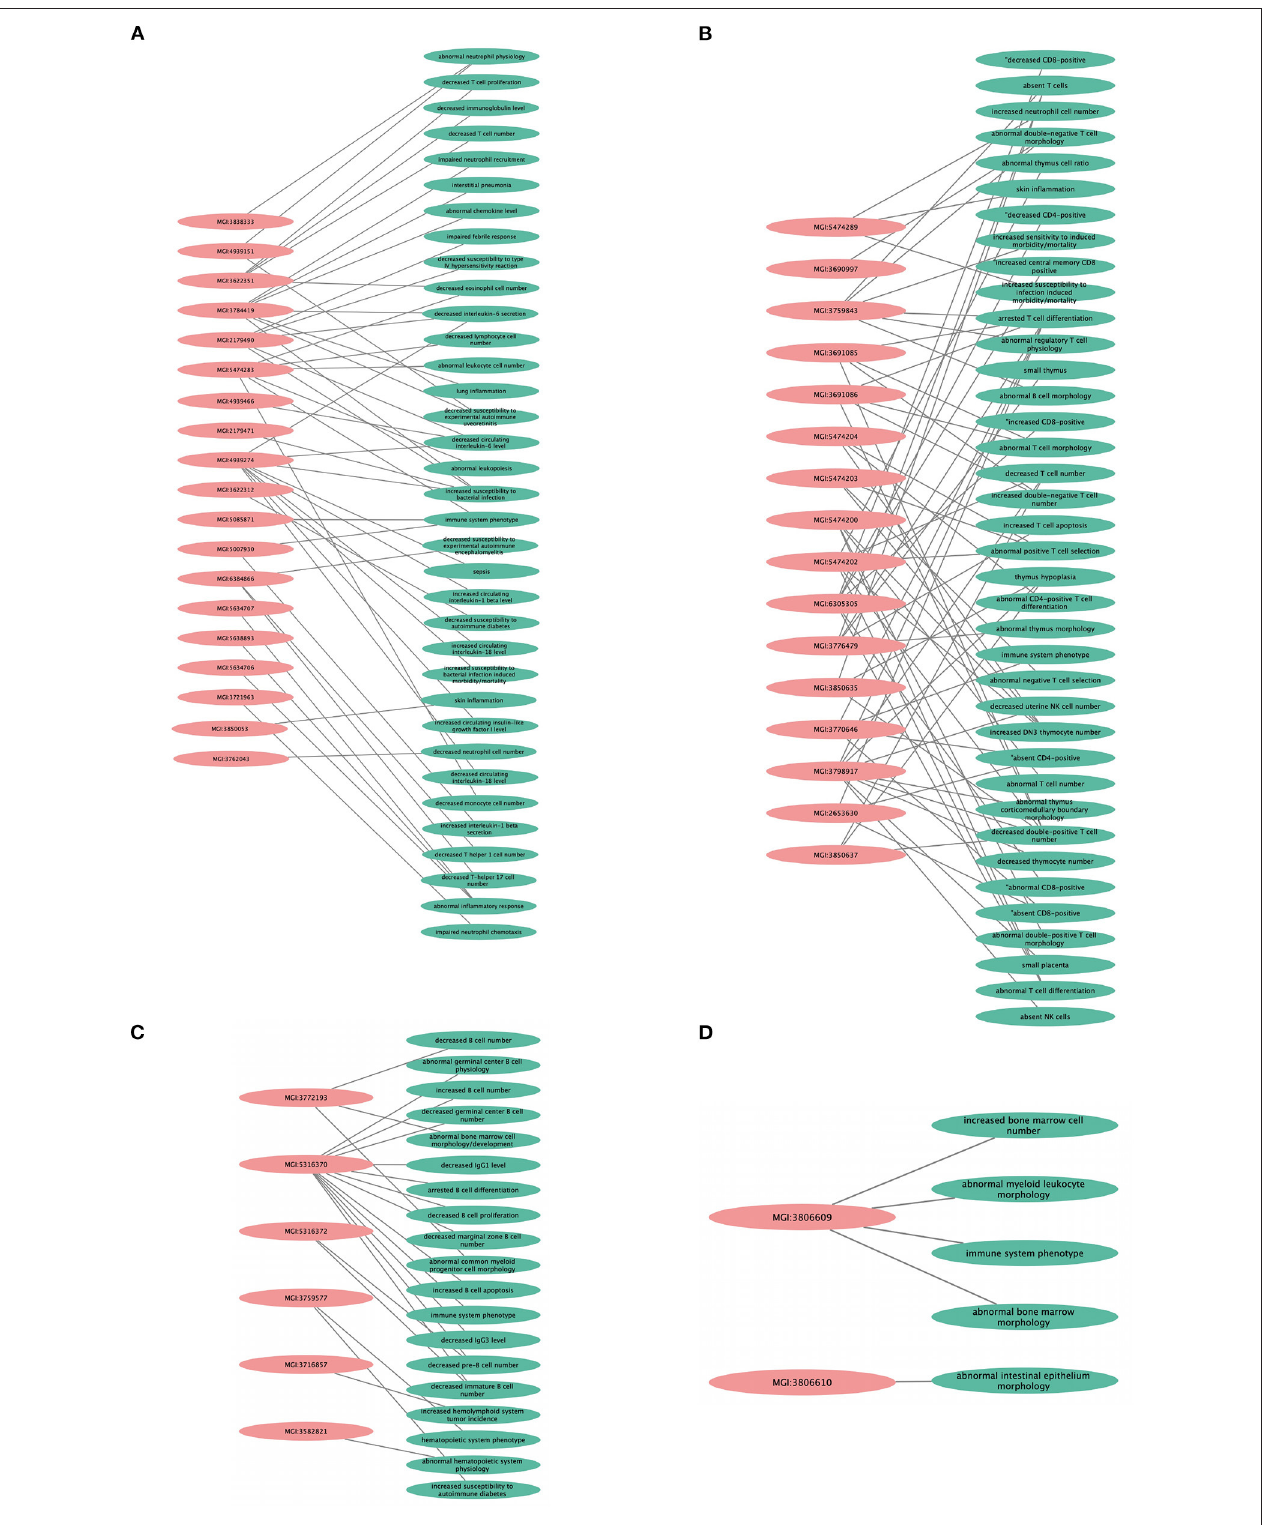
FIGURE 5 | Knockout mouse phenotype model analysis result from Mouse Genome Information (MGI) database for the selected genes, like (A) IL1R1, (B) CD3E, (C) POLR2A, and (D) CCNE1. The figure represents immune-related altered phenotypes (green) with the corresponding mice genotype ID (pink), visualized using Cytoscape 3.8.2